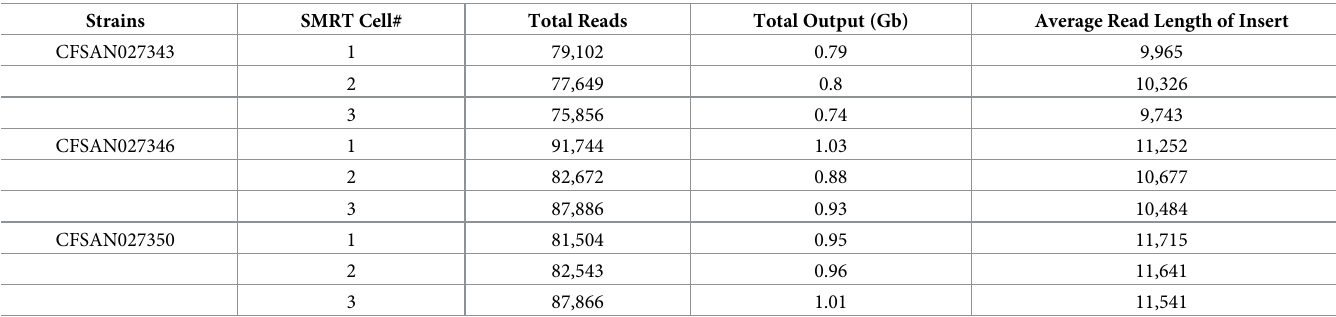
Table 5. PacBio sequencing output for each SMRT